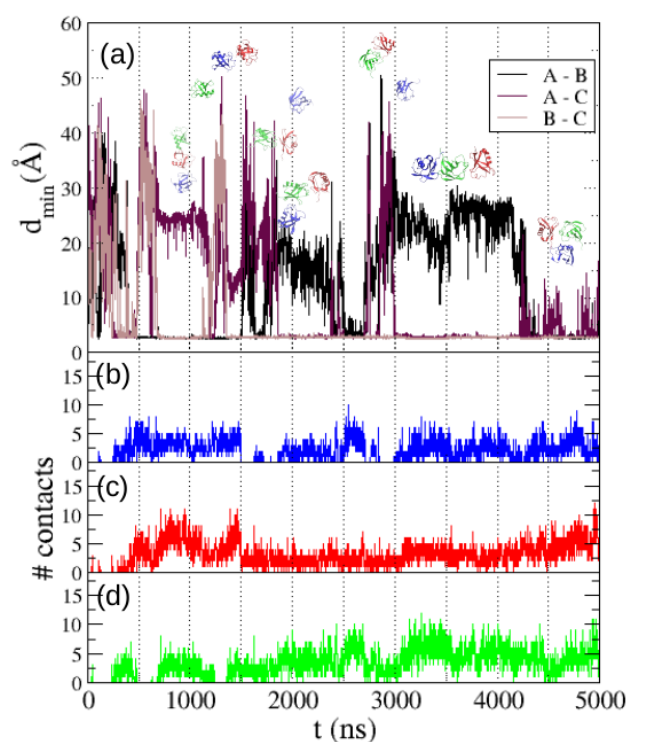
Figure 7. ( a ) Same as Figure 4a when 3 molecules are included in the simulation. The distances between the three molecules (A, B and C) are shown. System configurations at several points of the trajectory are shown. Also shown the number of intermolecular contacts formed by ( b ) molecule A, ( c ) molecule B and ( d ) molecule